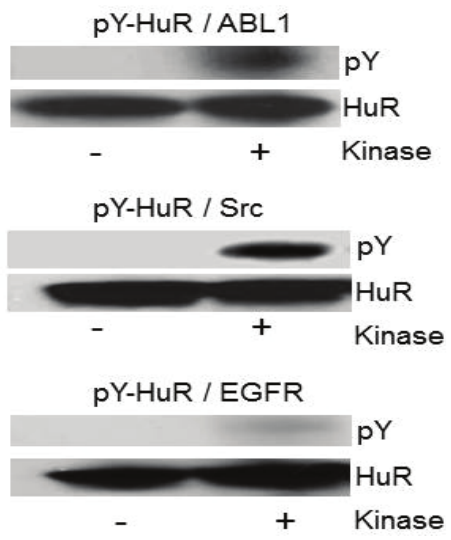
Figure 5. Recombinant HuR protein phosphorylation by Abl-1 and SRC kinases, in vitro . The phosphorylation of recombinant HuR protein (200 ng) by recombinant ABL1, Src and EGFR kinases detected with pY antibody in Western blots. Note the significant HuR phosphorylation by Abl-1 and SRC kinases.